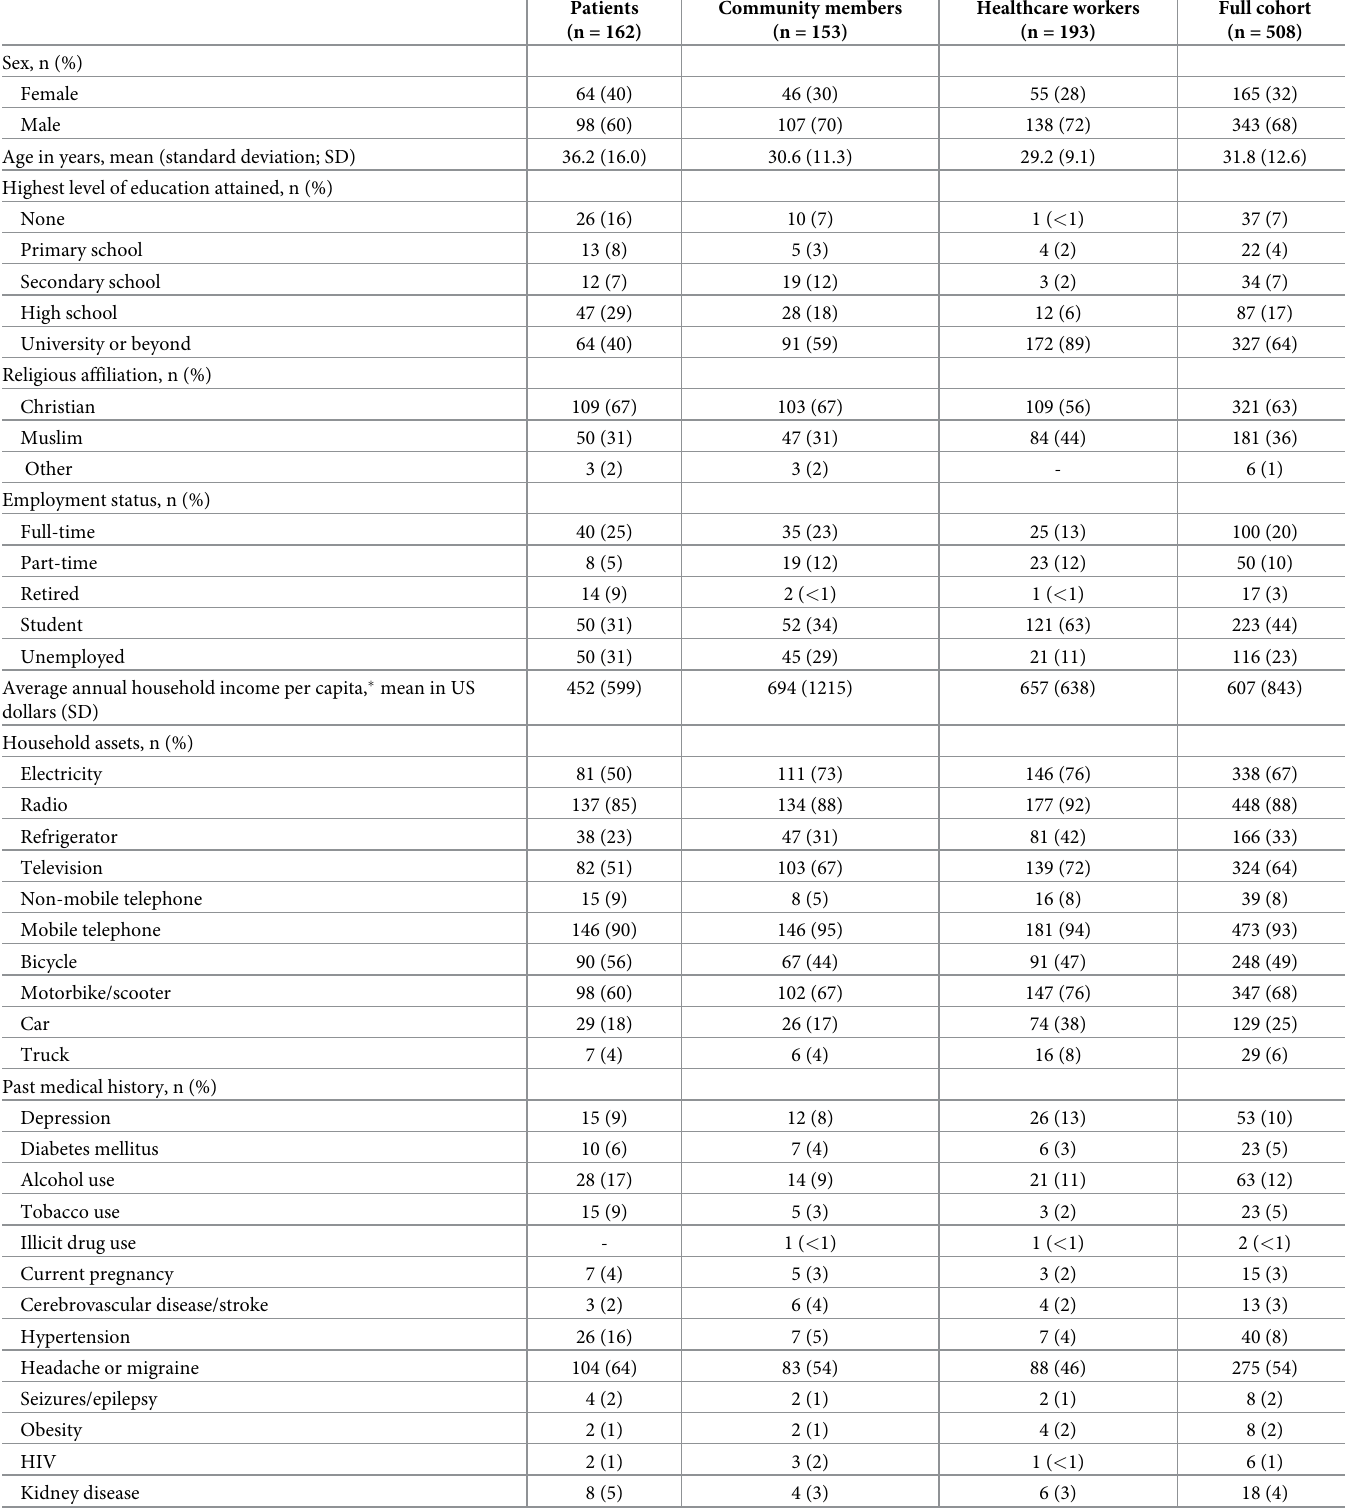
Table 1. Participant sociodemographic and clinical